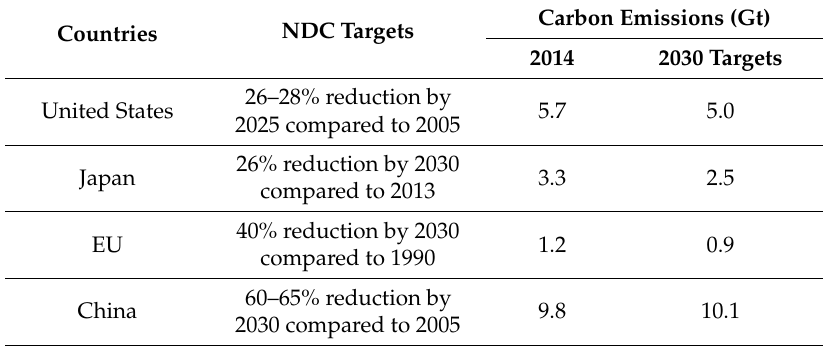
Table 1. NDC targets for major countries